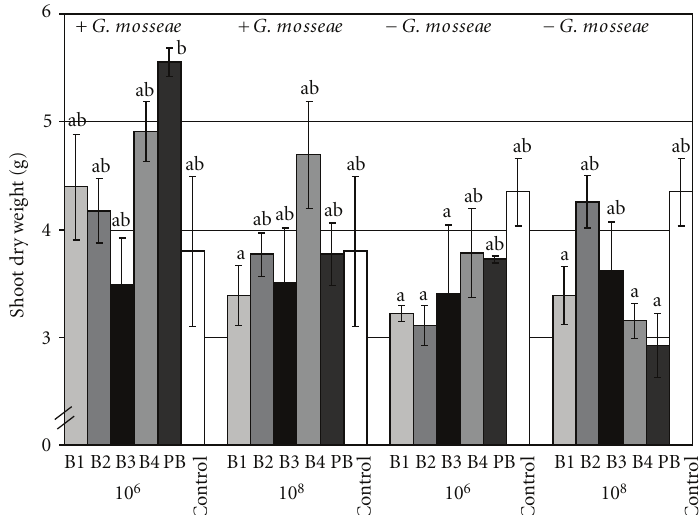
Figure 3: Average dry weight of shoots at harvest (15 weeks) from wheat plants inoculated with G. mosseae and/or di ff erent paenibacilli strains (B1–B4 and PB177) at concentrations of 10 6 or 10 8 bacterial cells 10 g − 1 of seeds or left untreated. The same letters above the bars indicate treatments without significant di ff erences ( P > . 05). Error bars represent the standard error of the mean.